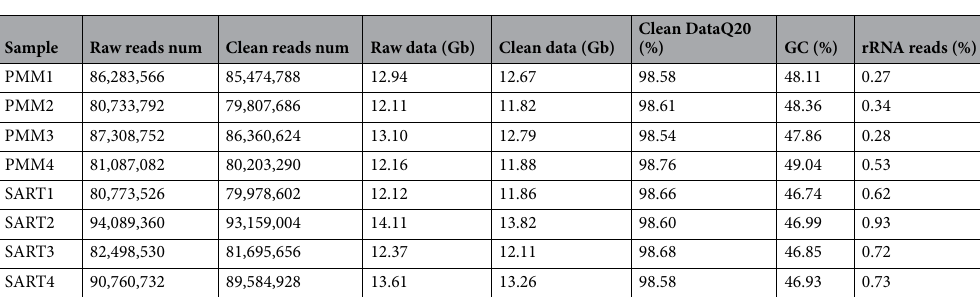
Table 1. RNA-seq date quality evaluation.